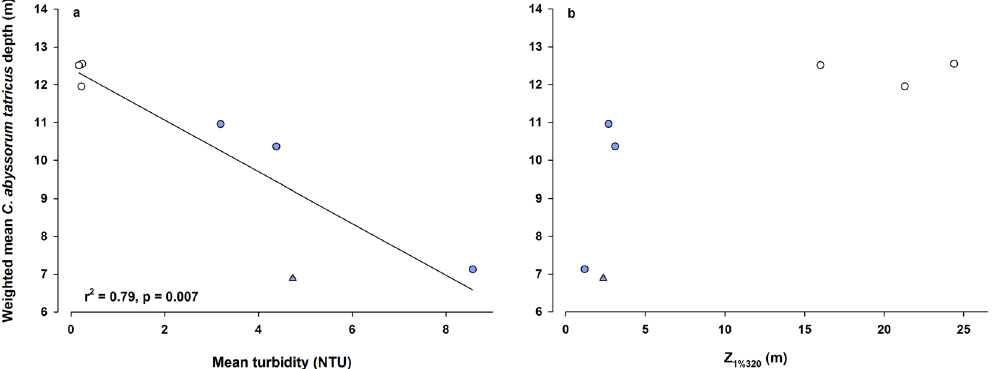
Figure 3. Weighted mean Cyclops abyssorum tatricus depth vs. ( a ) the mean turbidity and ( b ) 1% of the surface irradiance at 320 nm (Z 1%320 ) when considering only the three study lakes without fish. Open circles: clear lake FAS4, closed circles: turbid FAS3, and closed triangles: turbid FAS6 (abbreviations for the lakes are defined in Table